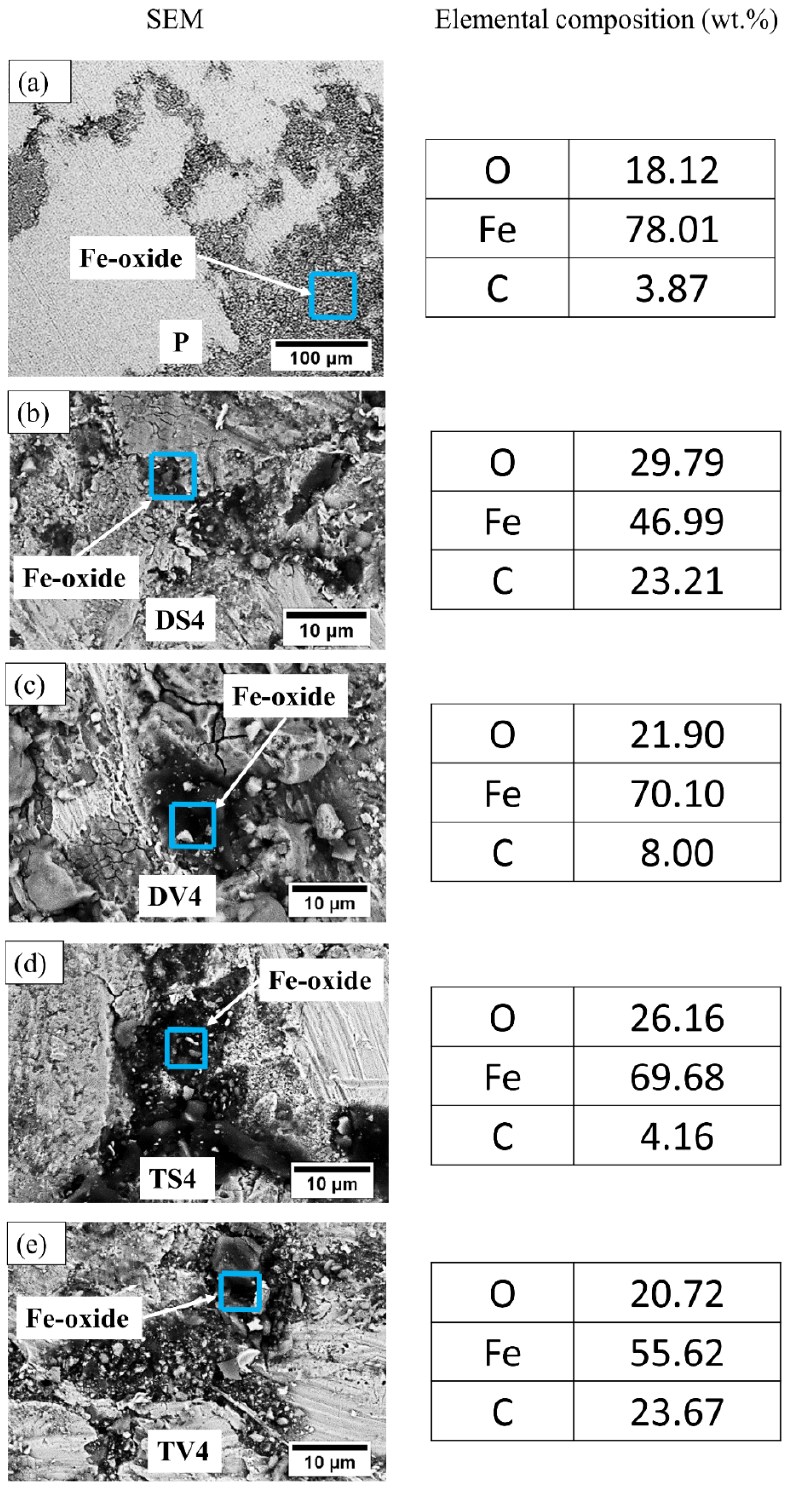
Figure 12. ( a – e ) SEM micrographs and EDX elemental composition corresponding to the worn cutting edge showing the presence of oxygen rich areas.